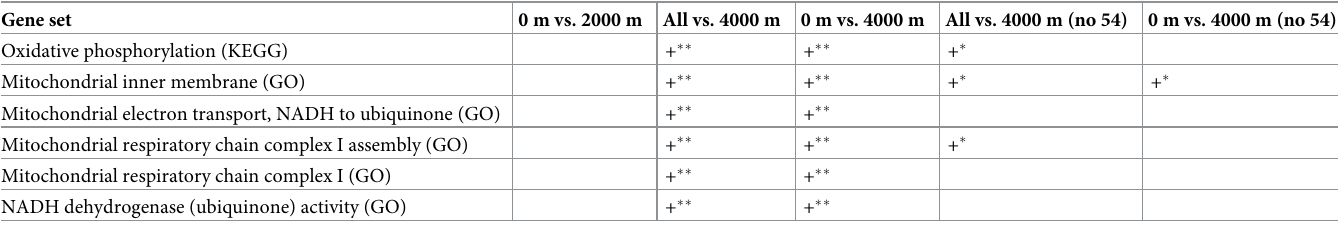
Table 2. Summary of all significant GSEA results. Gene set